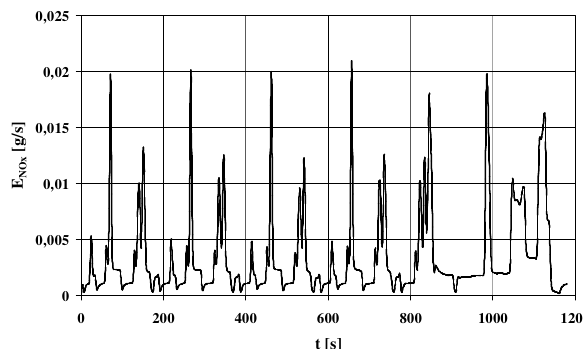
Fig. 7. Mean relative torque value in the NEDC and Malta tests